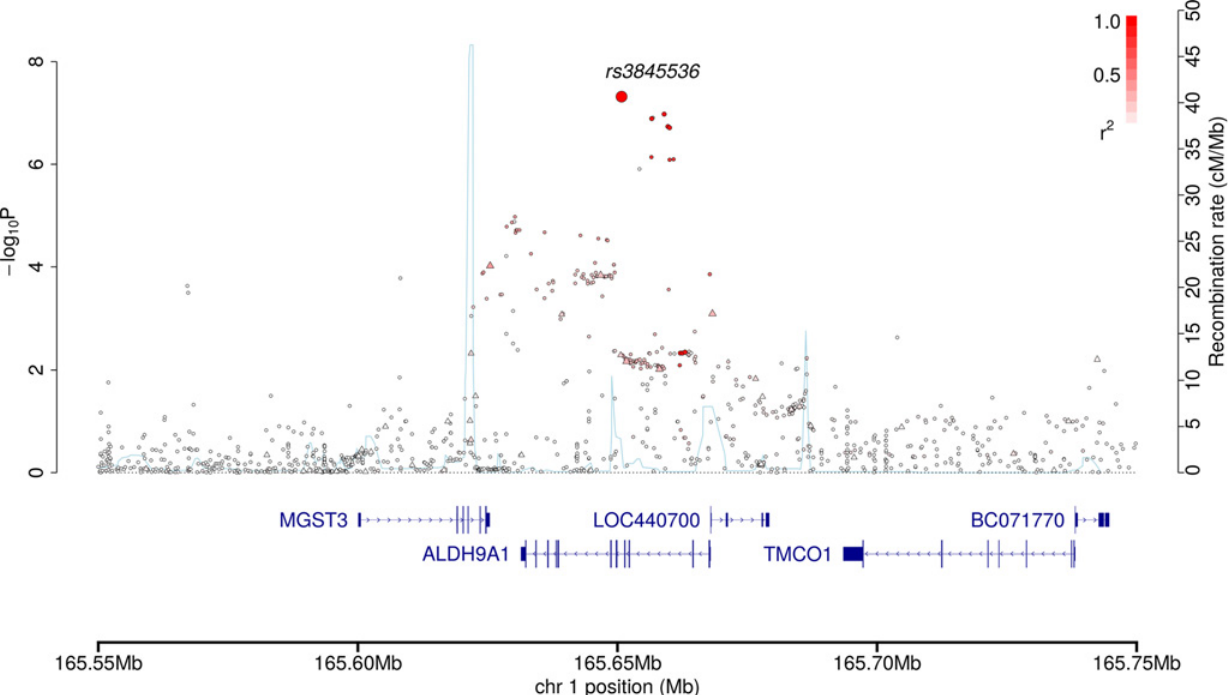
Fig 2. Regional association plot of the 1q24.1 risk locus. The figure shows − log 10 P values (y-axis) versus chromosomal positions (x-axis; NCBI build 37). Genotyped SNPs are shown as triangles, with imputed SNPs as circles. rs3845536 has been highlighted through the use of a larger symbol. Colour intensity is proportional to LD with rs3845536: from white ( r 2 = 0) to red ( r 2 = 1.0). The light blue line indicates genetic recombination rates (estimated from 1000 Genomes Phase 1 CEU data). Nearby genes and transcripts are also shown.